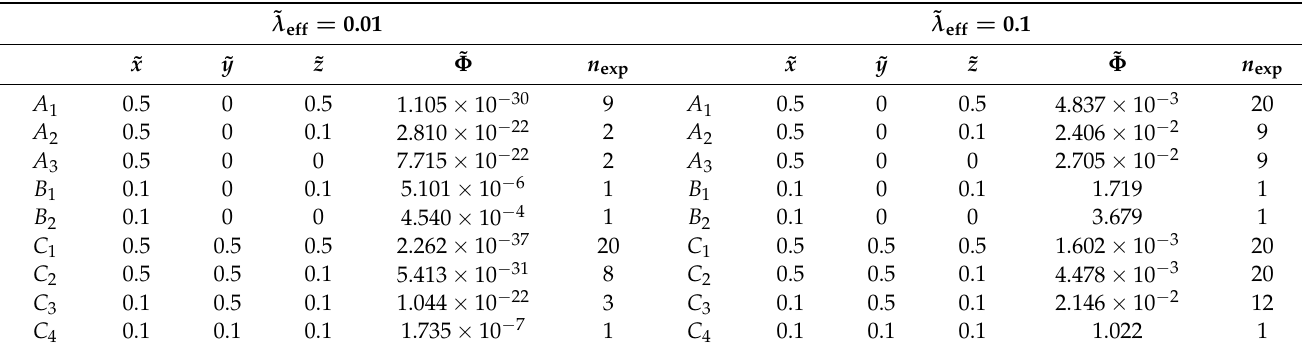
Table 1. Rescaled potential ˜ Φ and the corresponding numbers n exp of terms in the series sum at nine points in the cell for ˜ λ = 0.01 (left chart) and ˜ λ = 0.1 (right chart). eff eff ˜ λ = 0.01 ˜ λ eff